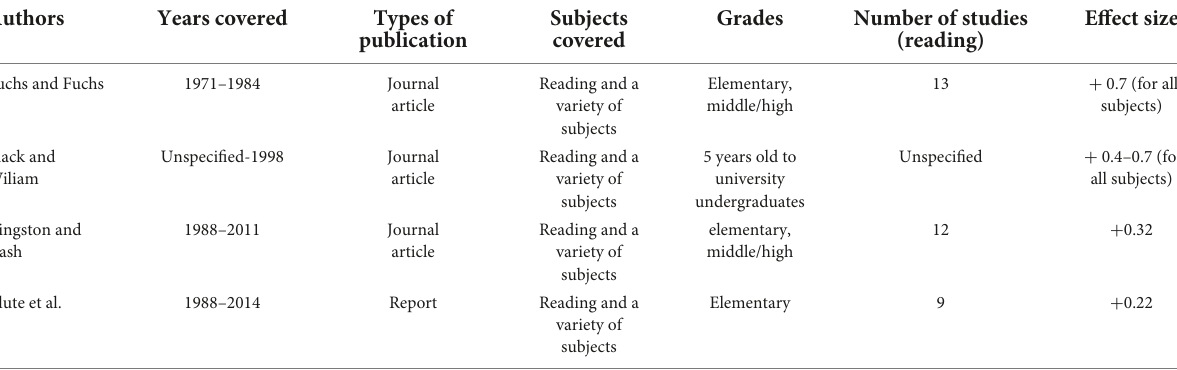
TABLE 1 Summary of major meta-analysis on effects of formative assessment on reading achievement.